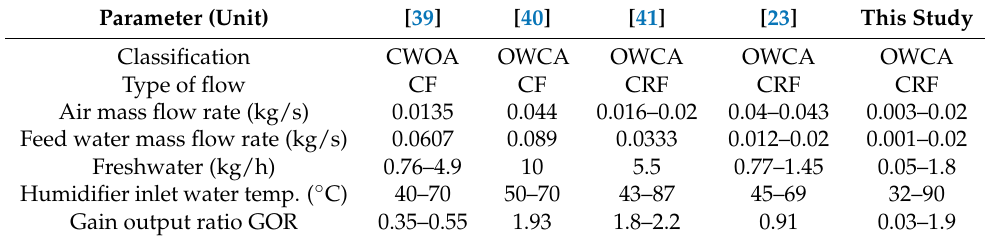
Table 1. Comparison to existing